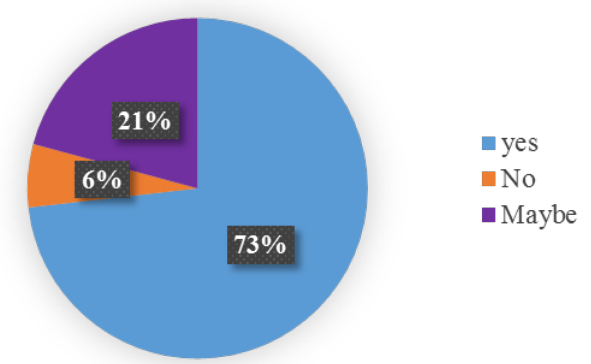
Figure - 4: Showing the usefulness of online learning for higher